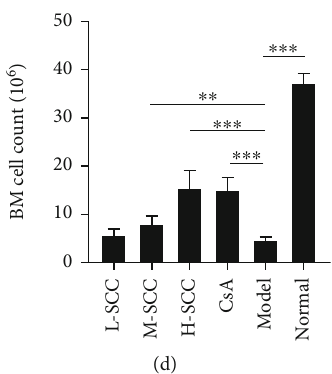
Figure 1: SCC improves hematopoiesis and reduces in fl ammatory factors in AA rats. (a, b) Comparison of peripheral blood cells and cytokine concentrations in various groups of rats ( n = 6 ). Results are presented in the bar charts, data are presented as mean ± SD . Statistically signi fi cant di ff erences are indicated by ∗ P < 0 : 05 ; ∗∗ P < 0 : 01 ; ∗∗∗ P < 0 : 001 . (c) Typical pictures of femoral bone marrow biopsies of rats in each group are shown by H&E staining, 200x. In which, a, b, and c represents model groups treated with SCC at low, medium and high dose, respectively, d for treatment group with CsA, e is the model group, and f is the normal